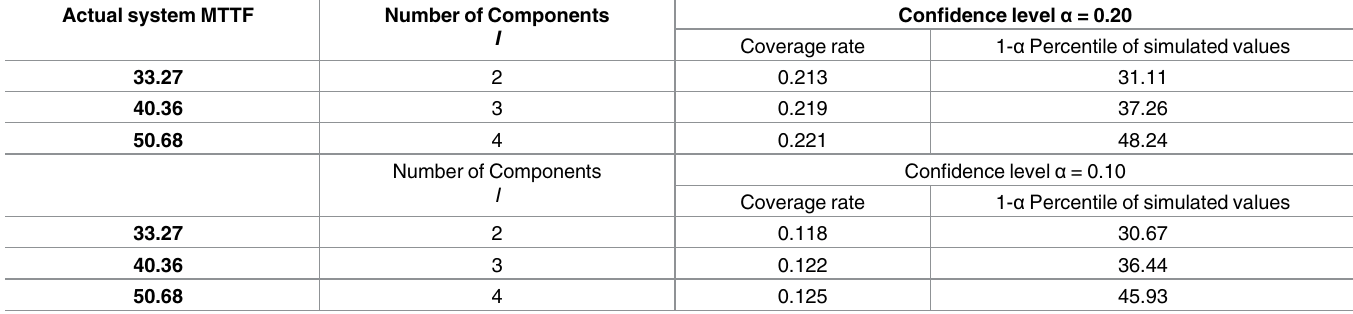
Table 6. Coverage rate of simulations results F (cid:0) 1 distribution. Actual system